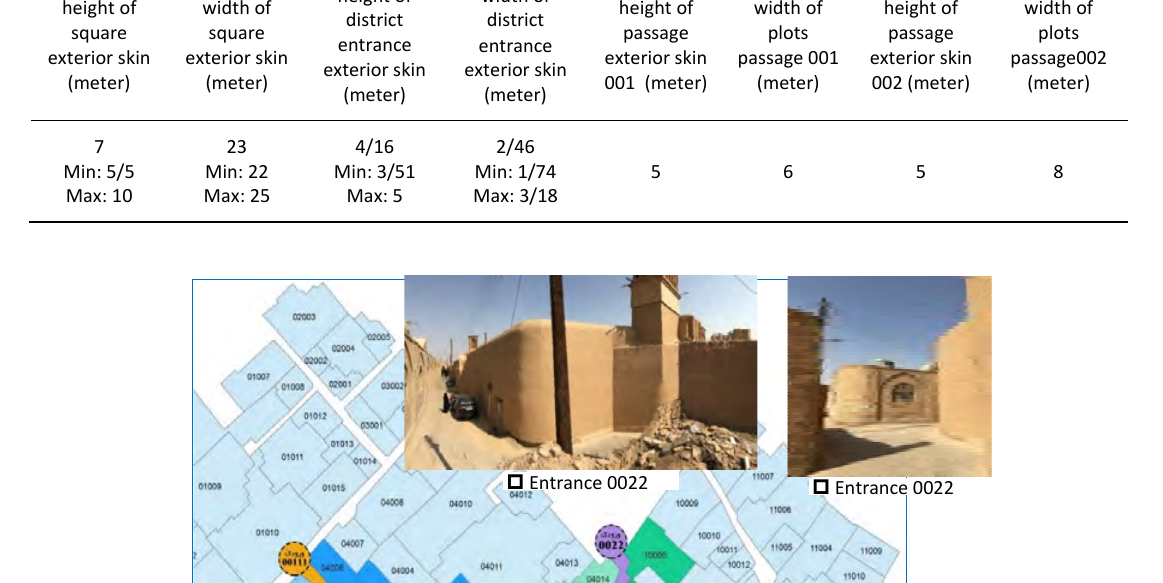
Average height of